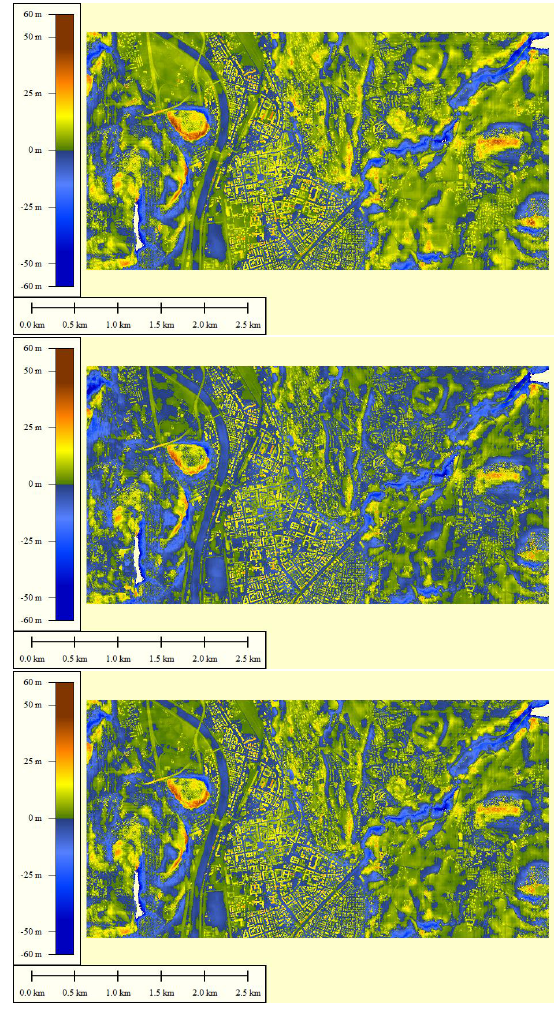
Figure 3: (a) Error map of the median DSM of the ascending stack, (b) Error map of the median DSM of the descending stack and (c) Error map of the merged